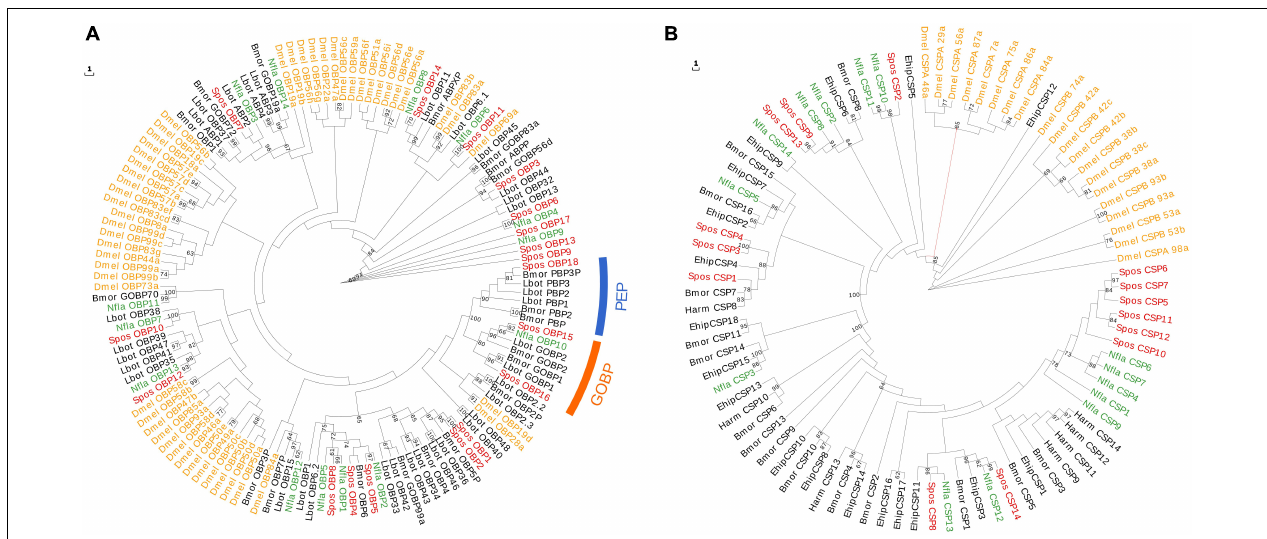
FIGURE 3 | Maximum-likelihood phylogenetic tree based on protein sequences of candidate odorant-binding proteins (OBPs) (A) and chemosensory proteins (CSPs) (B) . (A) The ML phylogenetic analysis of OBPs of N. flavidorsalis (Nfla OBP, green) and S. postornata (Spos OBP, red) were performed with reference OBPs of D. melanogaster (Dmel OBP, yellow) and OBPs of Lepidoptera species (black). The orange arch refers to PBP/GOBP lineage, and the blue arch refers to PEP. (B) The ML phylogenetic analysis of OBPs of N. flavidorsalis (Nfla CSP, green) and S. postornata (Spos CSP, red) were performed with reference CSPs of D. melanogaster (Dmel CSP, yellow) and CSPs of Lepidoptera species (black). The stability of the nodes was assessed by bootstrap analysis with 1000 replications, and only bootstrap values ≥ 0.6 are shown at the corresponding nodes.